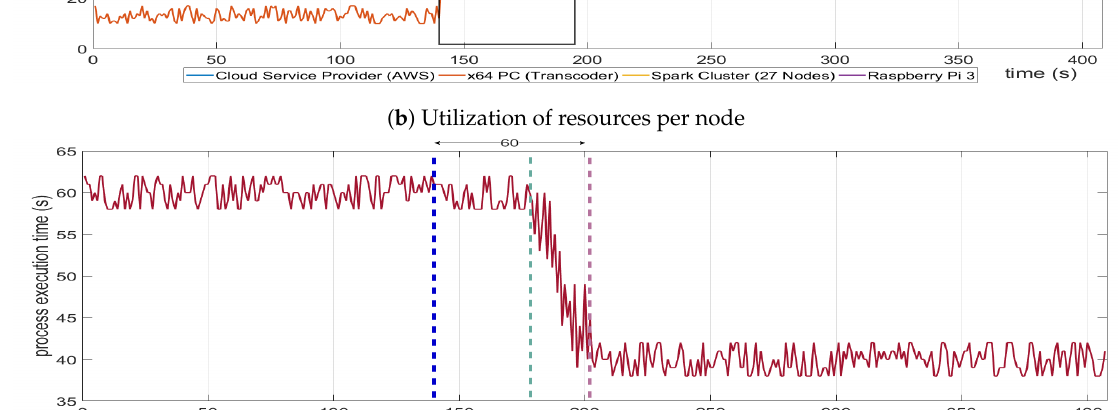
Figure 22. Resource Utilization